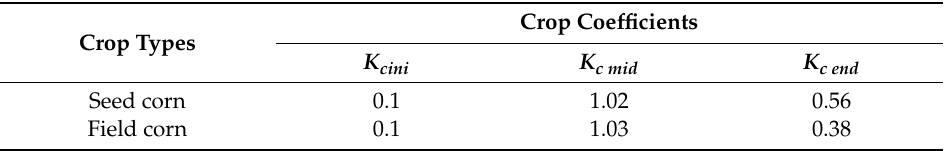
Table 2. Corrected values of crop